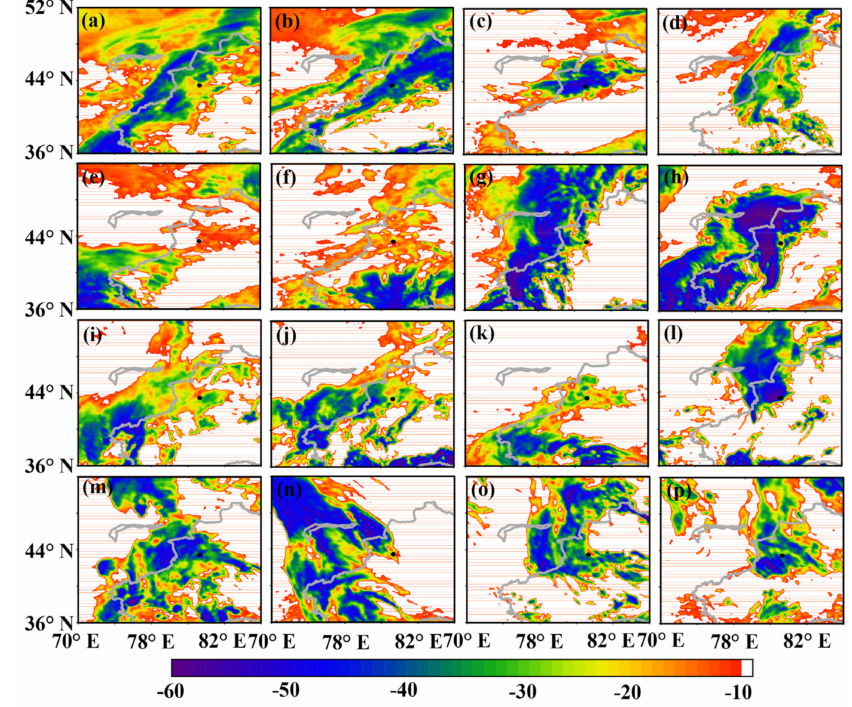
Figure 14. The TBB (black-body temperature) from FY-2G (Fengyun 2-G satellite) at the beginning of each rainfall event, rainfall event 1 to rainfall event 17 are ( a – p ), respectively (except rainfall event 16, because rainfall event 16 and rainfall event 15 are a ff ected by the same